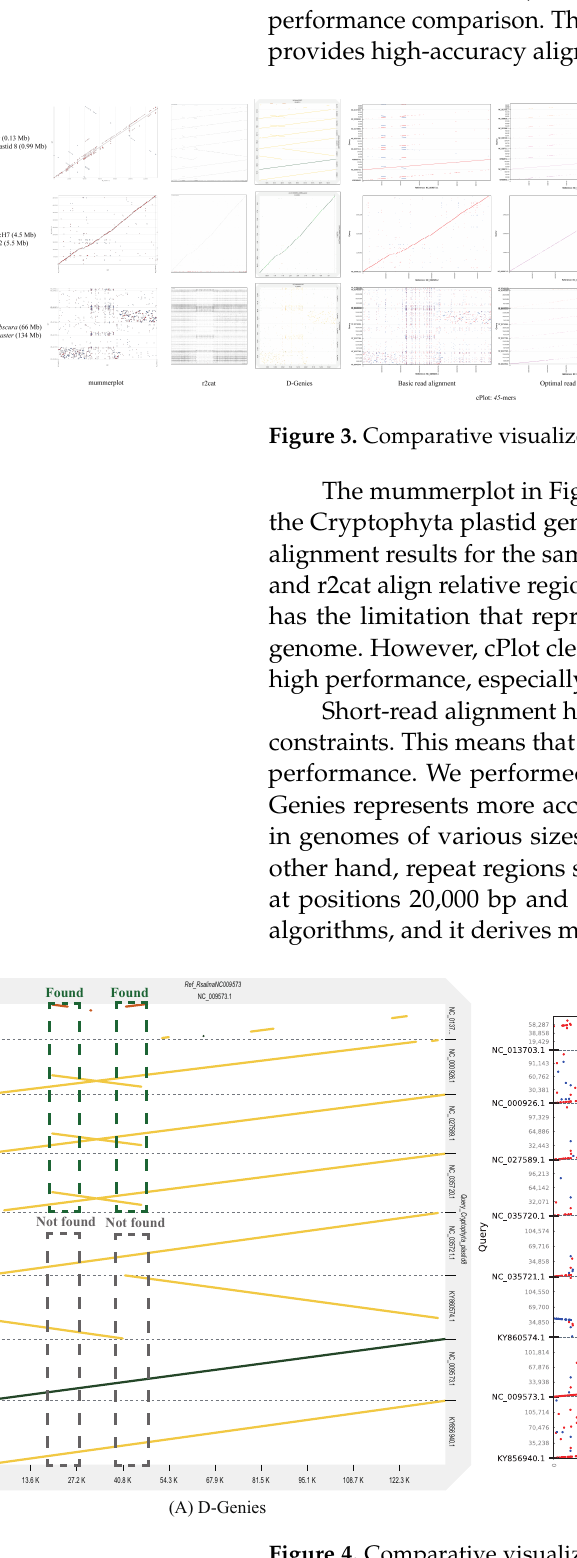
Figure 4. Comparative visualized analysis for repeat region. ( A ) D-Genies represents from 20,000 bp to 40,000 bp of four Cryptophyta plastid genomes as one alignment. ( B ) cPlot identifies repeat regions at 20,000 bp and 40,000 positions in all Cryptophyta plastid